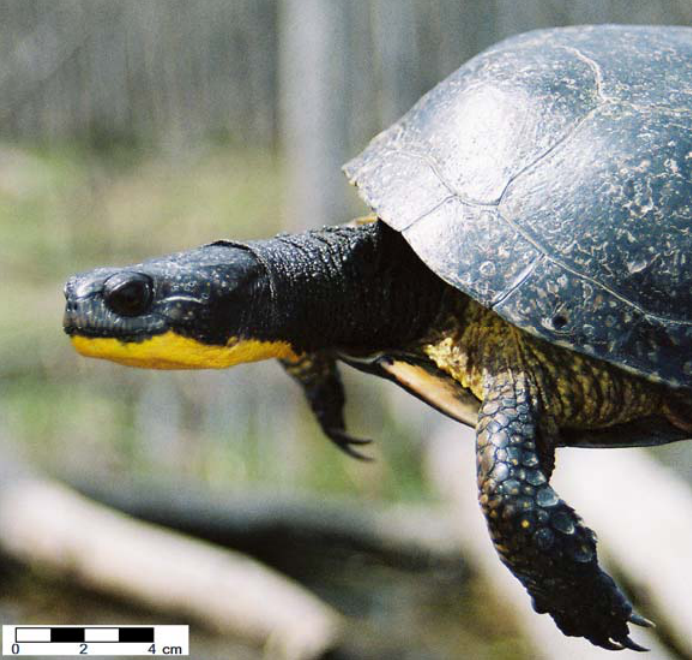
Figure 1. A Blanding’s turtle. Observation made during 2008 population inventory in Québec [5]. Scale is